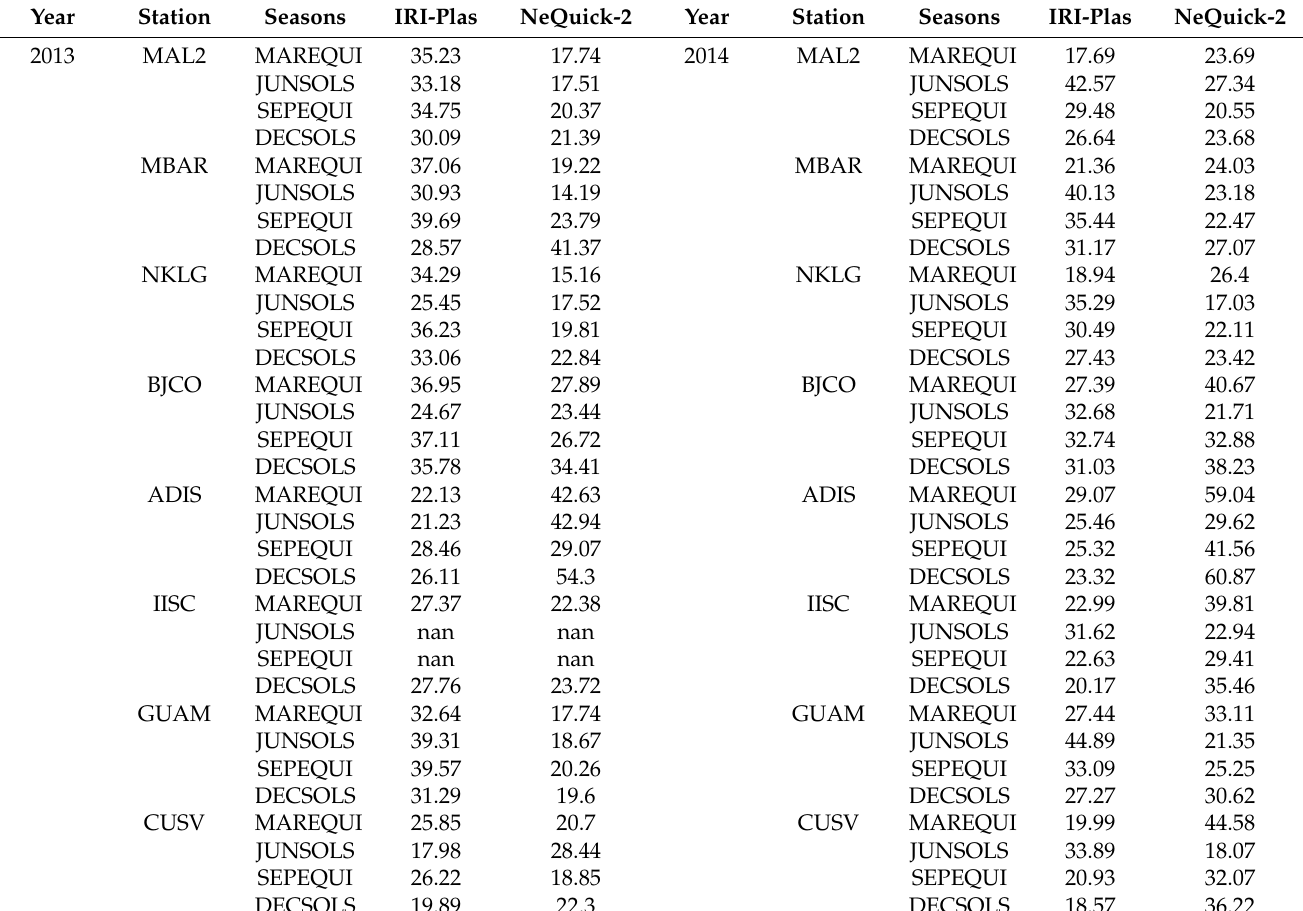
Table 3. % Root Mean Square Deviations (%RMSD) of the IRI-Plas and NeQuick-2 TEC Values from the GPS-TEC Values for the four Seasons at different stations during 2013 and 2014.